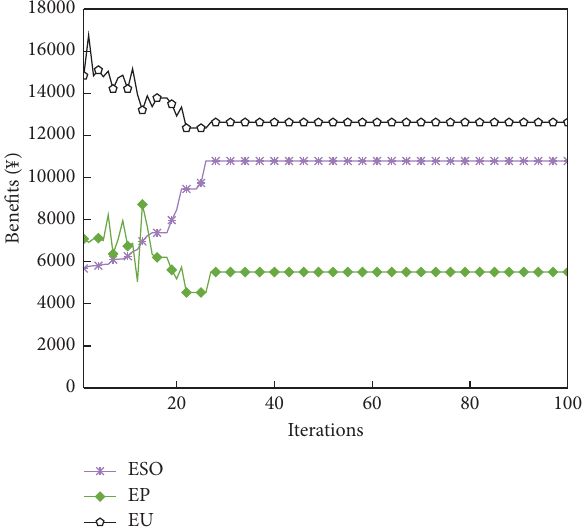
Figure 8: Te convergence curves of income of each player.